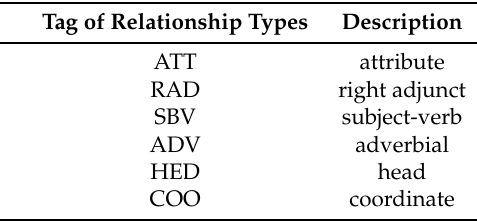
Table 4. The syntactic relations.